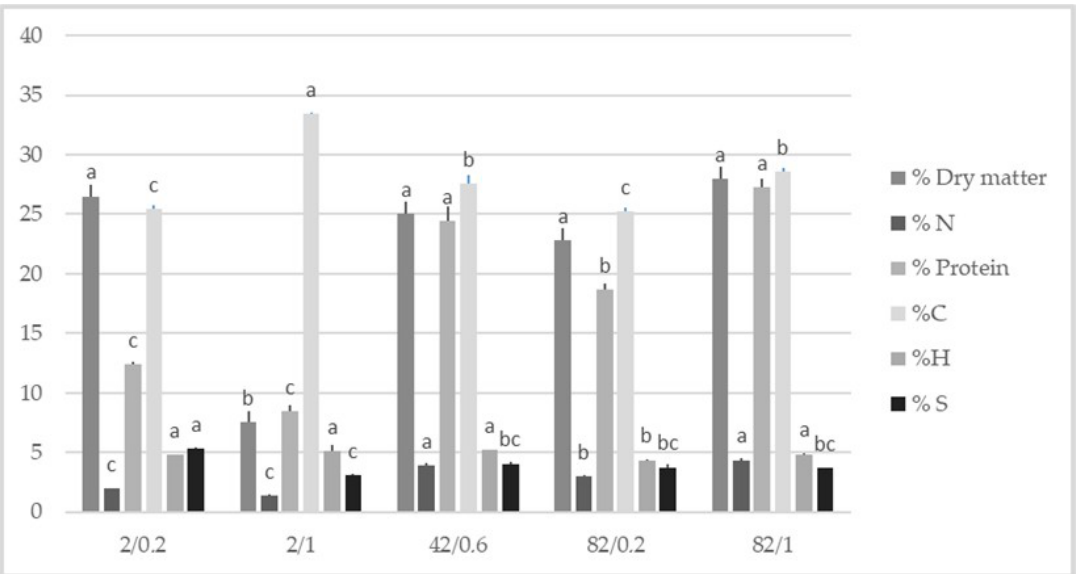
Figure 11. Percentages of dry matter and of the different elements (N, C, H, S) depending on the levels of N and P. The calculation of proteins has been carried out by multiplying the percent of N by 6.25 [35]. Different letters indicate significant diferences ( p <